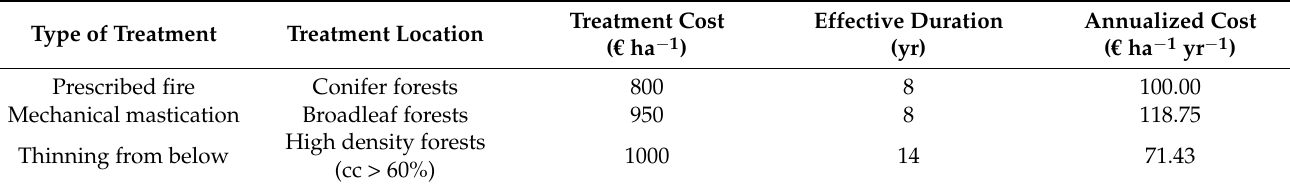
Table 1. Summary table with treatment cost data for fuel reductions in SMPs. The overstory is first reduced to a 60% canopy cover implementing a thinning from below, followed by prescribed fire (in conifer forest) or mechanical mastication (in broadleaved forests). We assumed average cost conditions for ongoing fuel reduction